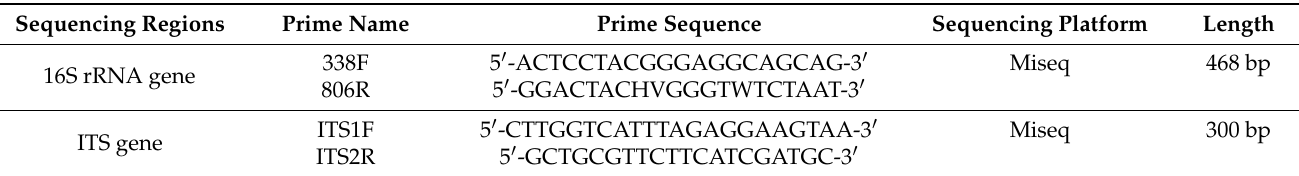
Table 2. Sequencing types and primer